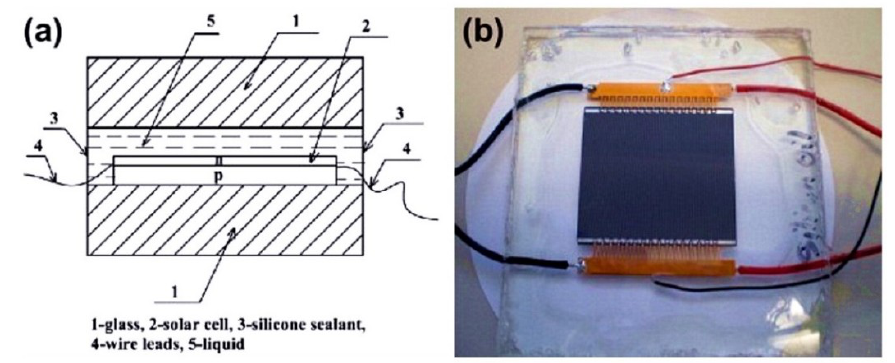
Figure 11. ( a ) Schematic cross-section of mini-module; ( b ) one mini-module with silicon CPV solar cell (3 immersed in dimethyl silicon oil designed for 1.5 mm test) [77].